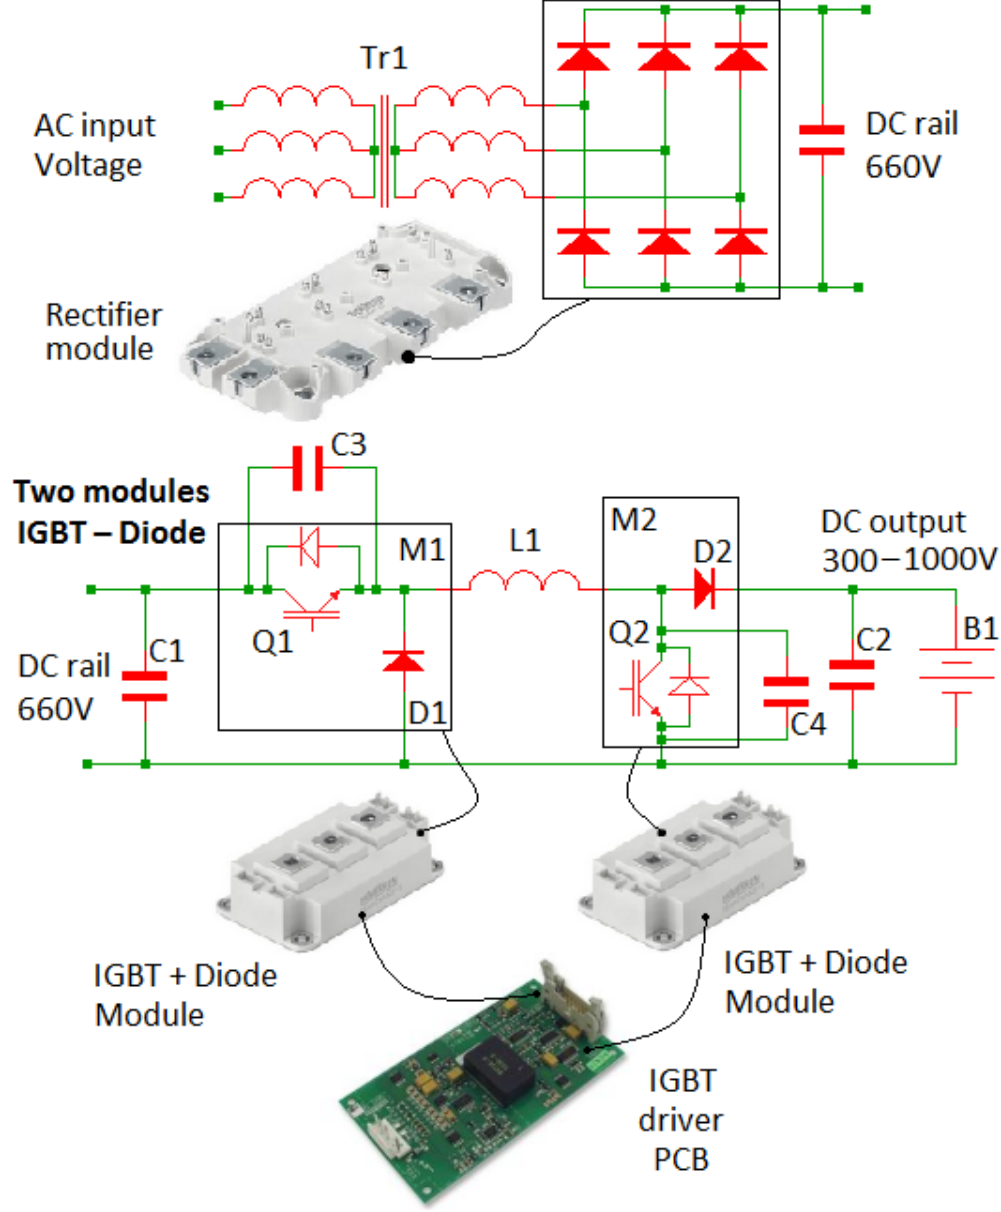
Figure 2. The proposed Buck-Boost converter for fast charge, based on isolated gate bipolar transistor (IGBT) modules (see Table A1 Appendix A).